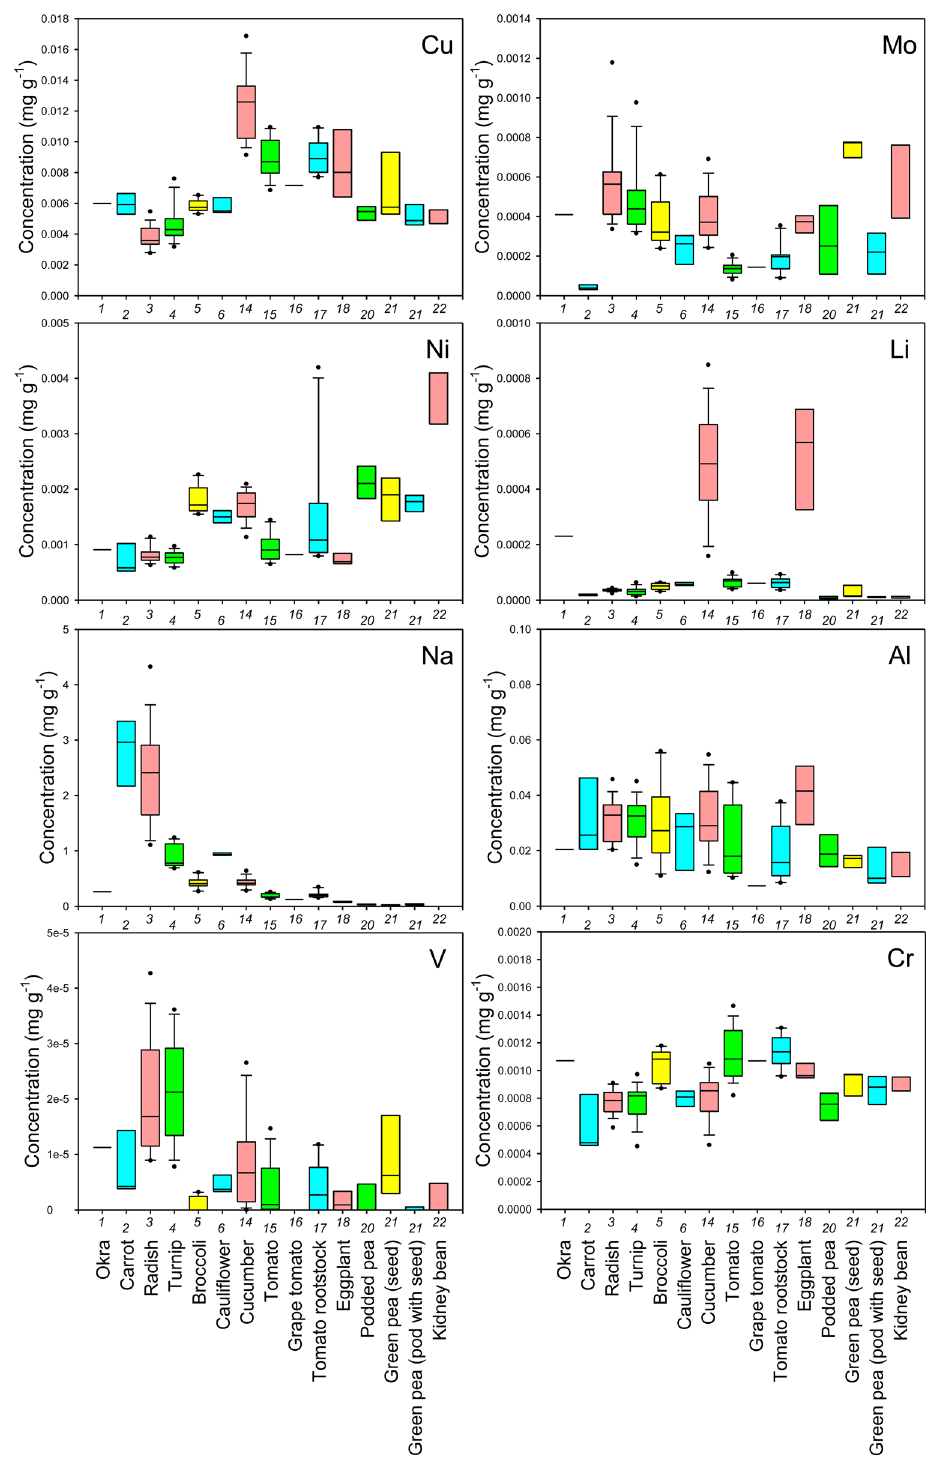
Fig 5. Boxplots showing the concentration of Cu, Mo, Ni, Li, Na, Al, V, and Cr in non-leaf edible parts of various crop species. Numbers in x-axis indicate the species number in Table 1.